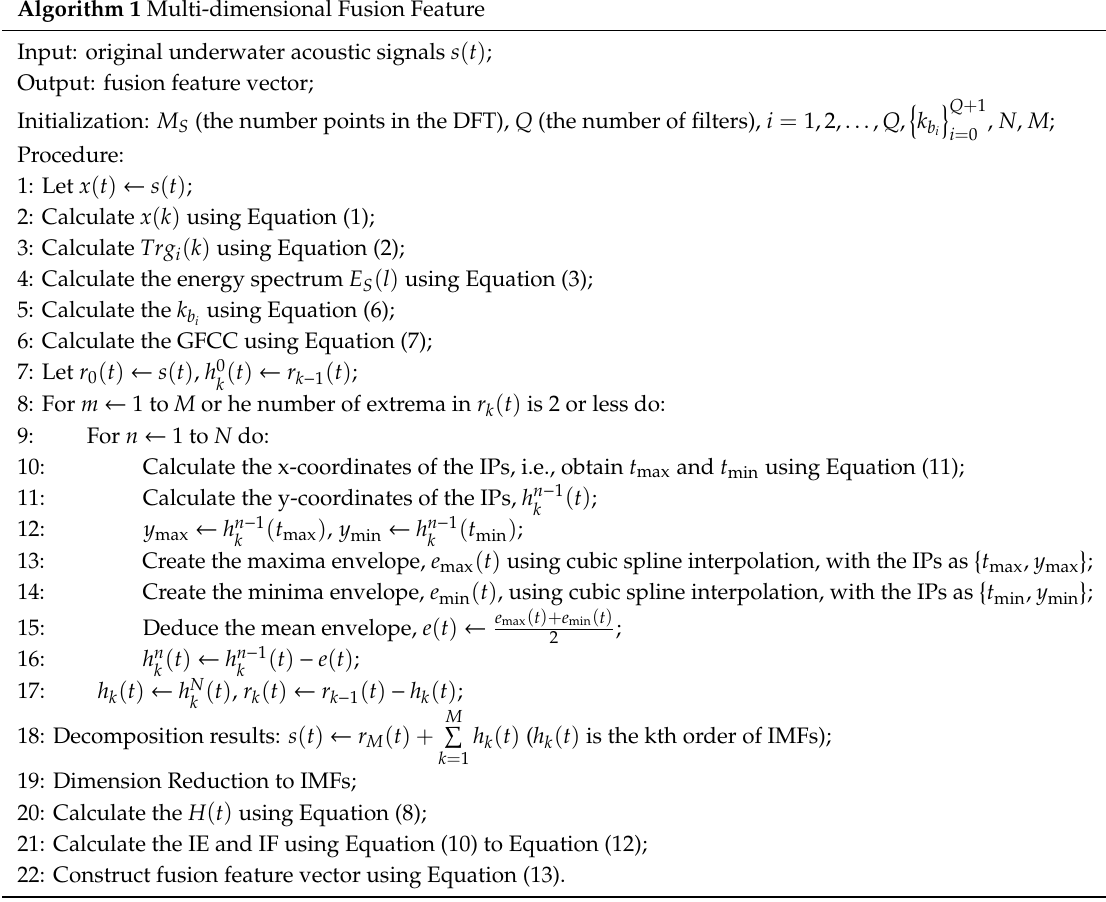
Algorithm 1 Multi-dimensional Fusion